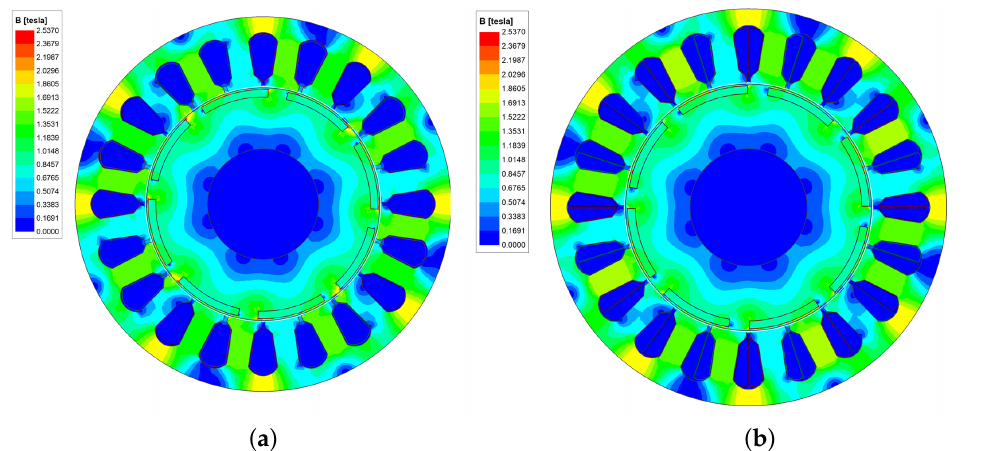
Figure 12. Magnetic flux density cloud map under full load condition. ( a ) Single-turn winding distribution. ( b ) Double-layer winding